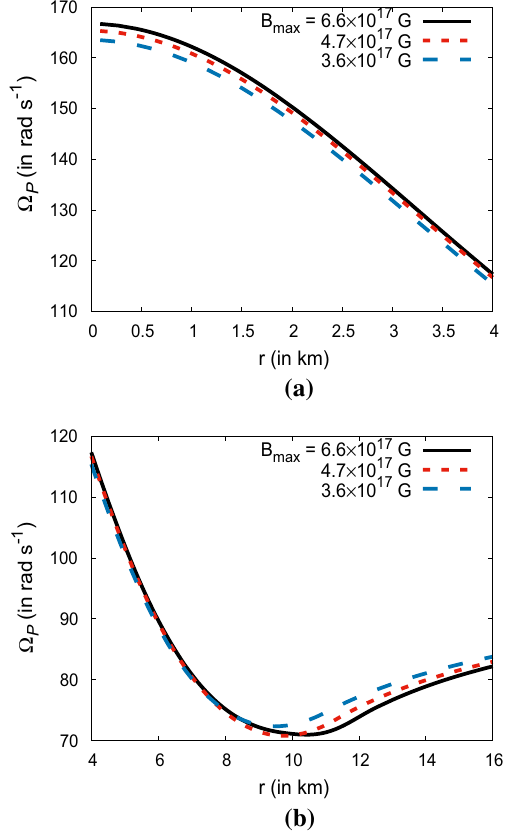
Fig. 23 WehaveplottedtheeffectofaTTtypeofmagneticfieldonthe variation of Ω P with distance from center along the equatorial plane a from center to 4 km, b from 4 to 16 km. The radius of the star is around 11 km. The black solid curve, the red short dashed curve and the blue dashed curve are for central magnetic field of 6 . 6 × 10 17 G , 4 . 7 × 10 17 G , 3 . 6 × 10 16 G respectively. Ω is taken to be 100 rad s − 1 . The central energy density of the NS is taken to be 1 . 0 × 10 15 g cm −